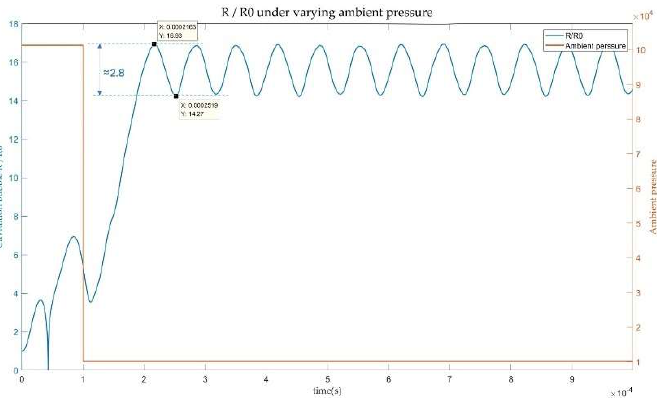
Figure 7. The growth curve of cavitation bubbles under the condition of changing ambient pressure.